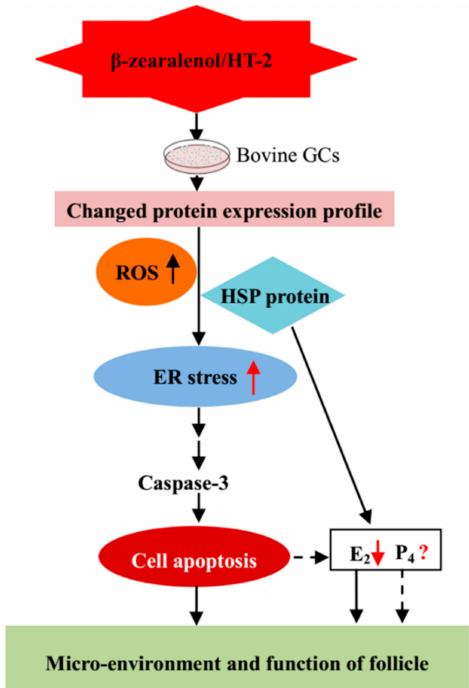
Figure 8. Schematic diagram of the e ff ects involved in β -zearalenol and HT-2 mycotoxin-treated GCs. The proposed e ff ects show that these mycotoxins could cause GC apoptosis, ROS-mediated ER stress, and impair hormone secretion, consequently disrupting the microenvironment and impairing the function of the